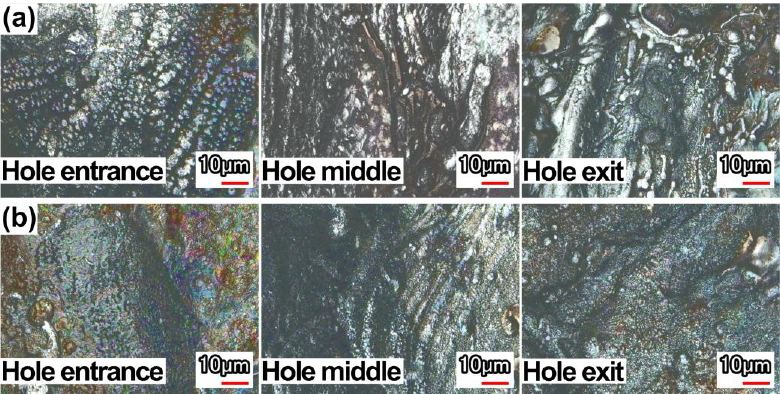
Figure 10. 2D morphology at different locations of hole sidewall: ( a ) in air, ( b ) water-based assistance.